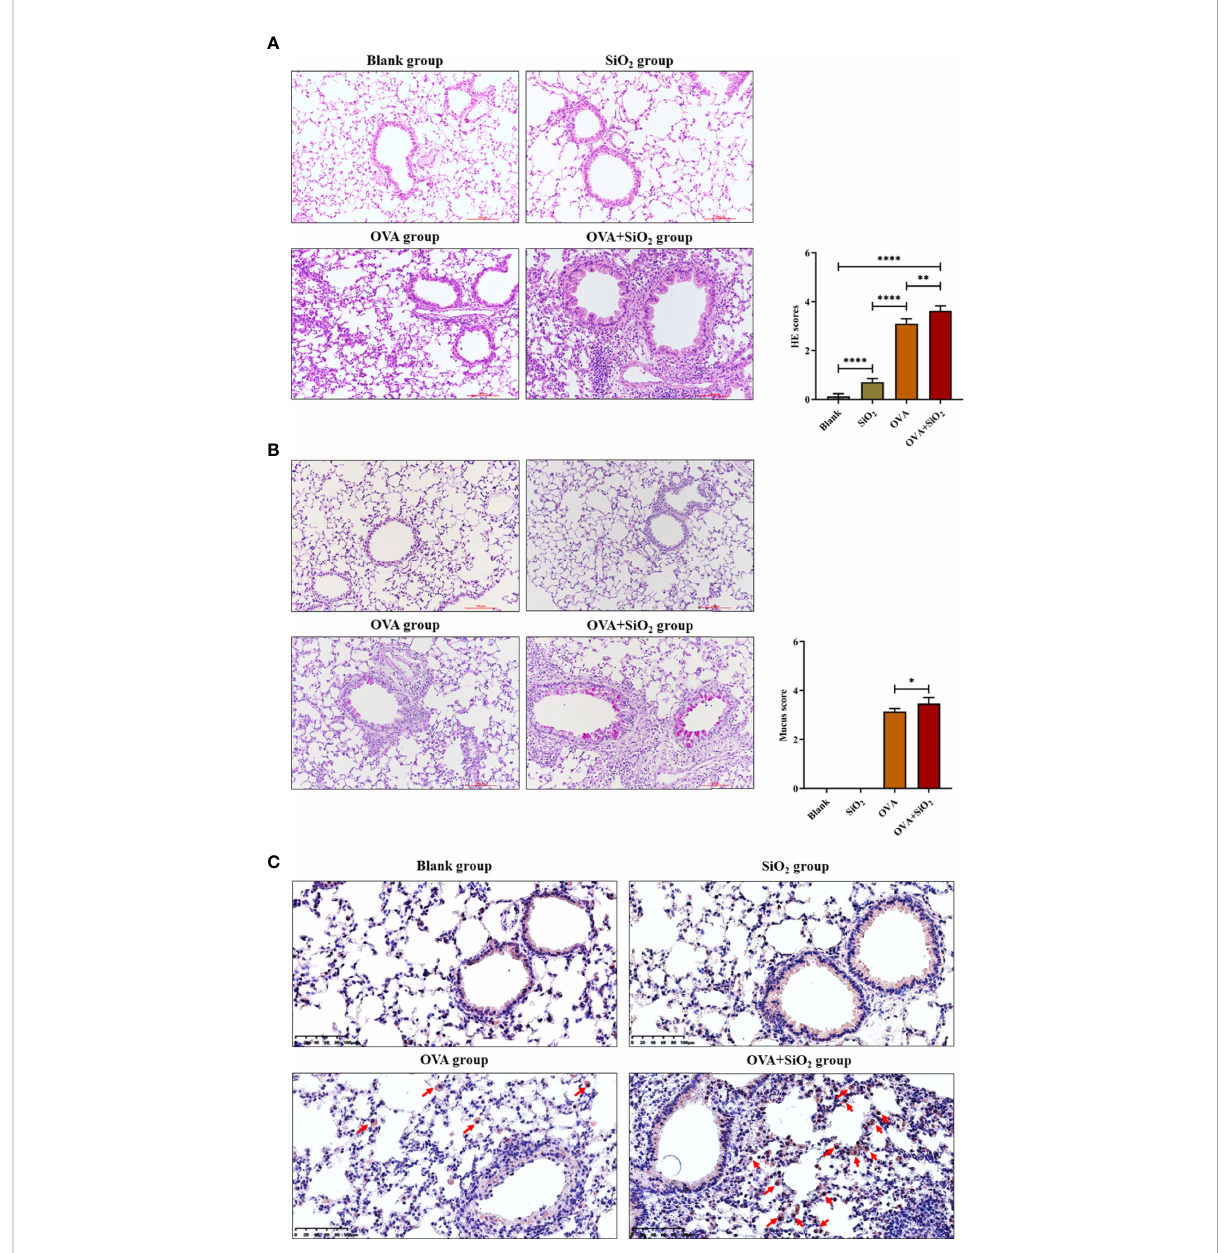
FIGURE 5 Representative images of lung histology and immunohistochemistry. (A) Lung tissue stained with hematoxylin and eosin (H&E) (× 200). (B) Lung tissue stained with periodic acid-Schiff stain (PAS) (× 200). (C) Immunohistochemistry analysis of mast cell tryptase in lung tissue. The arrow indicates anti-mast cell tryptase antibody-positive cells. Data are represented as the means ± SD. The unpaired t test was used to compare different groups. * P < 0.05, ** P < 0.01, **** P <